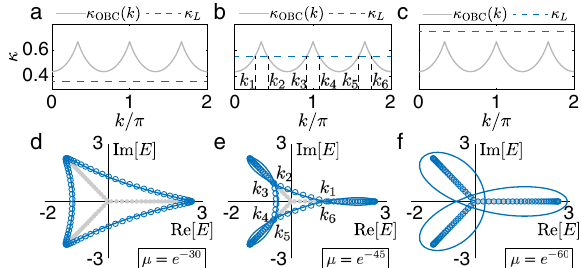
Fig. 4 Co-existence of the scale-free accumulation (SFA) and the non- Hermitian skin effect (NHSE). a – c Decaying exponents κ L and κ OBC ( k ) of the SFA and NHSE, respectively, for the Hamiltonian of Eq. (5) with different boundary impurities μ . d – f Their corresponding spectra under different parameters and different boundary conditions. The blue lines, blue circles, and gray dots in d – f correspond to the spectra of the SFA with eigenenergy given by E = ϵ ( k + i κ L ), numerical results with a boundary impurity, and the NHSE where E = ϵ ( k + i κ OBC ( k )) respectively, with ϵ ( k ) the eigenenergy under periodic boundary conditions. The system ’ s parameters are α = 1, L = 80, and μ = e − 30 , e − 45 , and e − 60 from left to prefect circle with its radius determined by μ . Requiring κ L ( μ c ) = κ